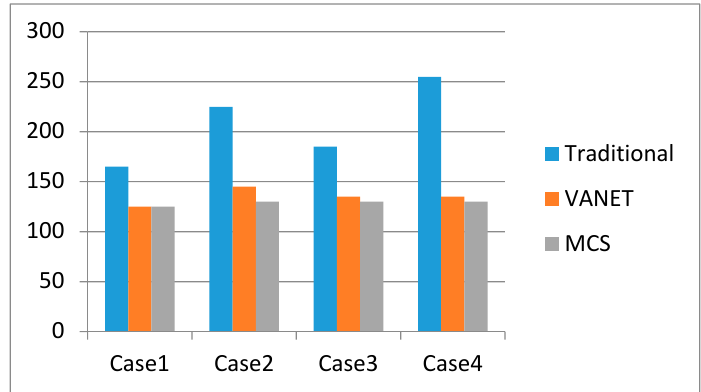
Figure 6. The distance travelled in the different cases.